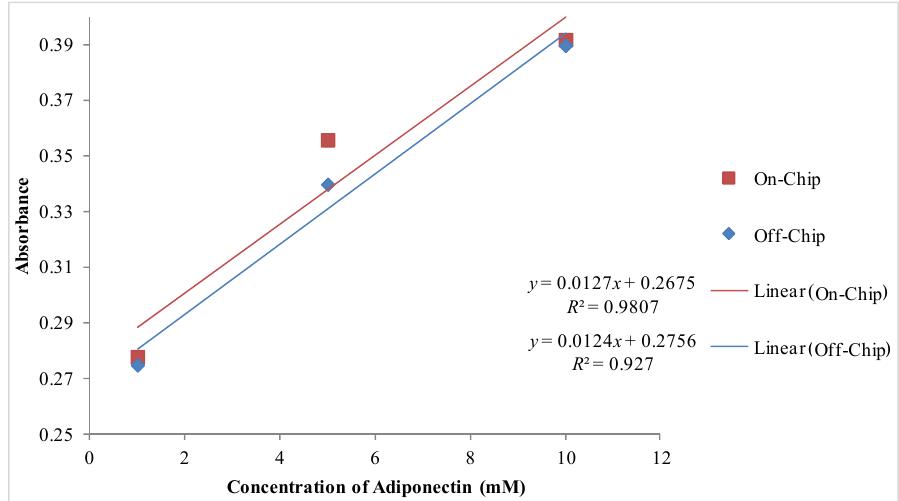
Figure 11. Analyte concentration vs . florescence (off-chip and